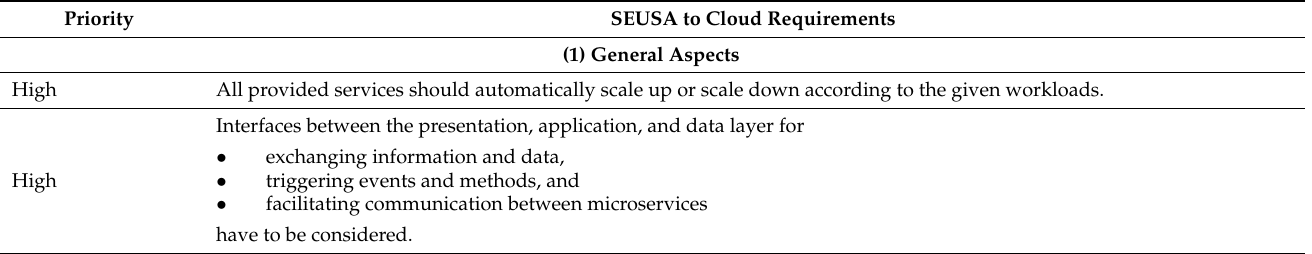
Table 1. SEUSA to cloud requirements. Requirements for the cloud-based development of the parallel and distributed SEUSA approach are divided into general requirements, SEUSA as a Service, parallel and distributed computing, tiling services, and cloud